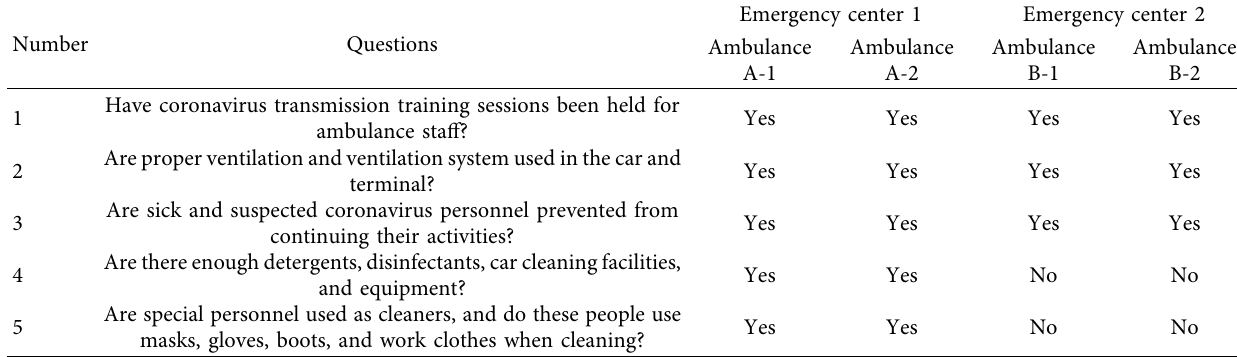
Table 7: Results of the evaluation of preventive criteria of centers.